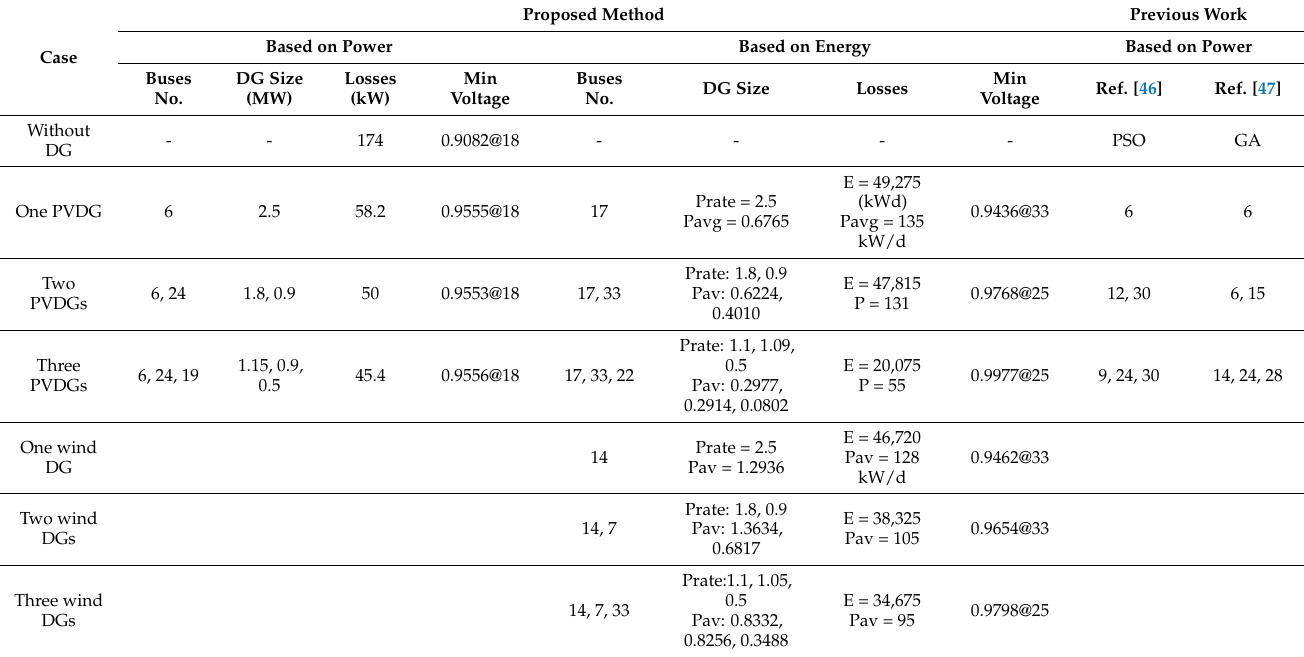
Table 3. The results of the proposed algorithm and compared with previous